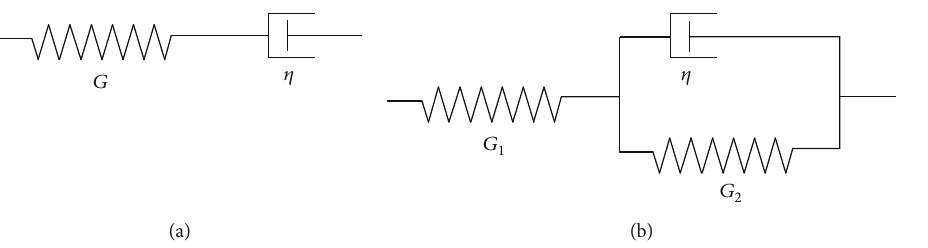
New surface Original surface